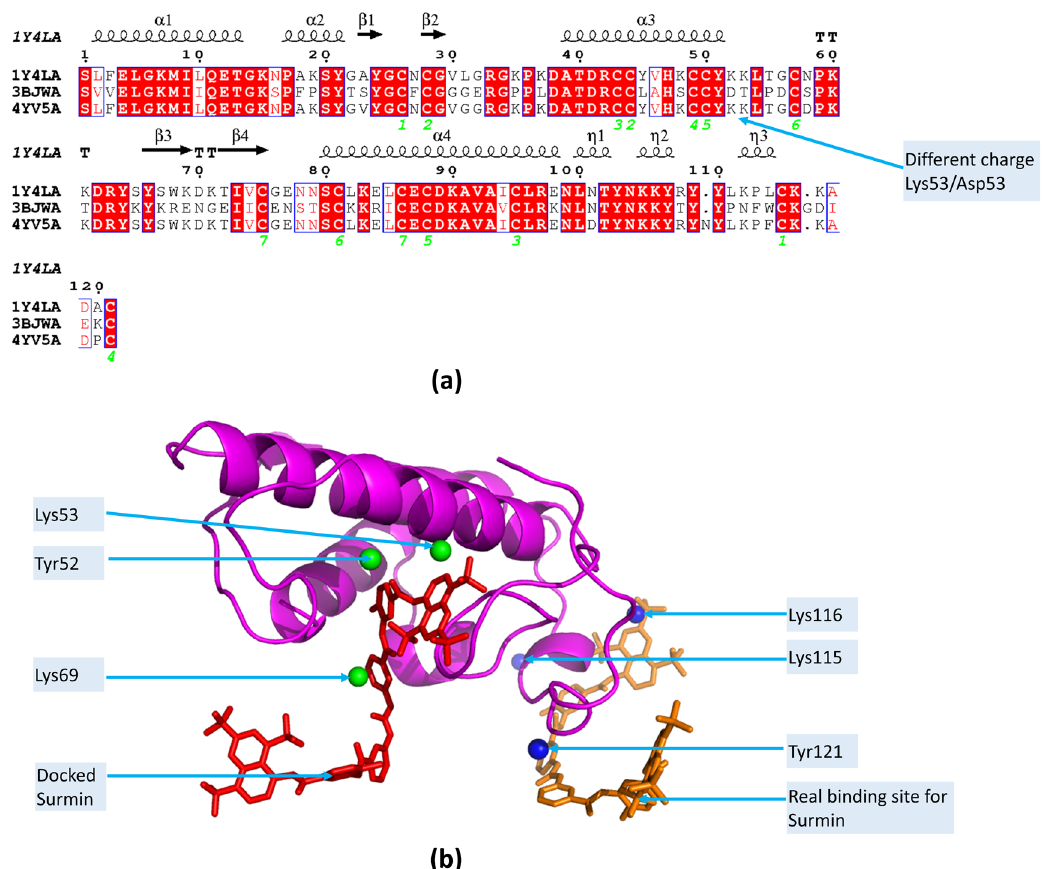
Figure 4. Non-specific binding of suramin to phospholipase A2-like proteins (PLA2). ( a ) MSA of three PLA2 from poisonous vipers: (i) PLA2-X, PDBid:1Y4L from Bothrops asper , (ii) PLA2-Y, PDBid:3BJW from Echis carinatus and (iii) PLA2-Z, PDBid:4YV5 from Bothrops moojen i shows that PLA2-Y is significantly different from the other two proteins in the charge composition of the residues. For example, the positively charged Lys53 which makes contact with suramin in PLA2-X, and is conserved in PLA2-Z, is replaced by the negatively charged Asp53 in PLA2-Y.( b ) The DOCLASP docked suramin to PLA2-Z based on the binding residues obtained from PLA2-X (Lys53, Lys69 and Tyr52) shows that there are two possible binding sites of suramin within PLA2-X/Z.